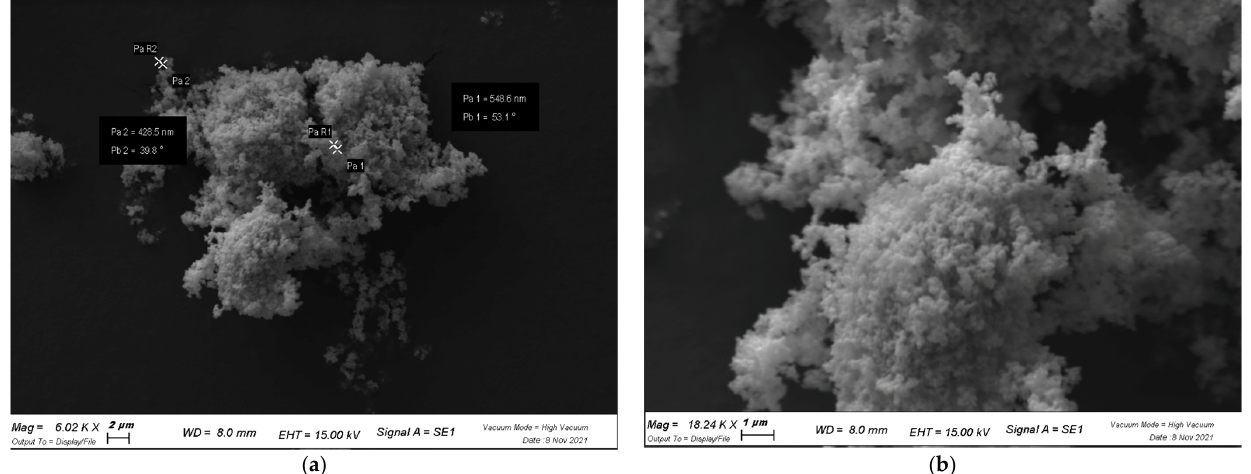
Figure 4. SEM image of Zinc Oxide, Sodium Lauroyl Glutamate, Lysine, Magnesium Chloride at different magnifications. ( a ) 6000× magnification; ( b ) 18,240× magnification.